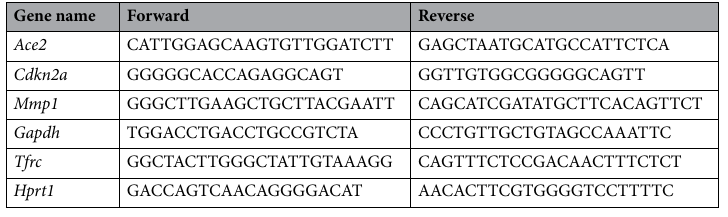
Table 2. Primers for